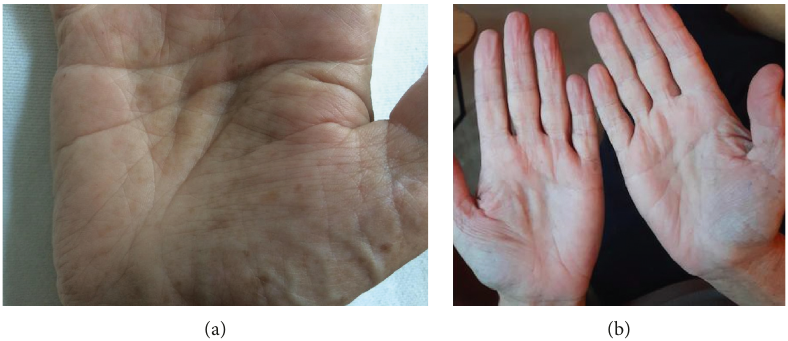
Figure 2: (a) Hyperpigmentation of hands before therapy. (b) Resolution of hyperpigmentation 9 months following therapy with infliximab.